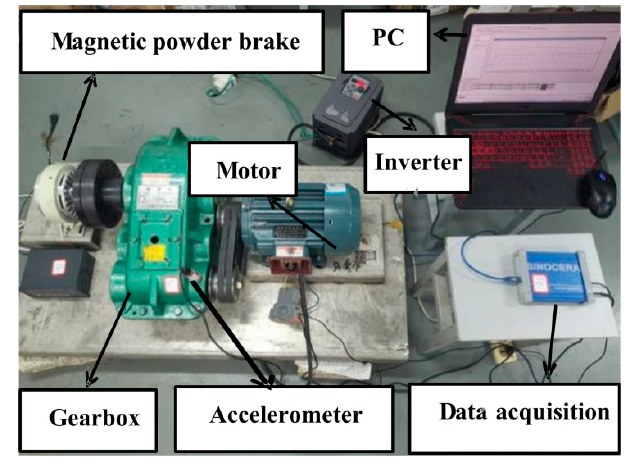
Figure 3. Gearbox fault diagnosis experimental test platform.